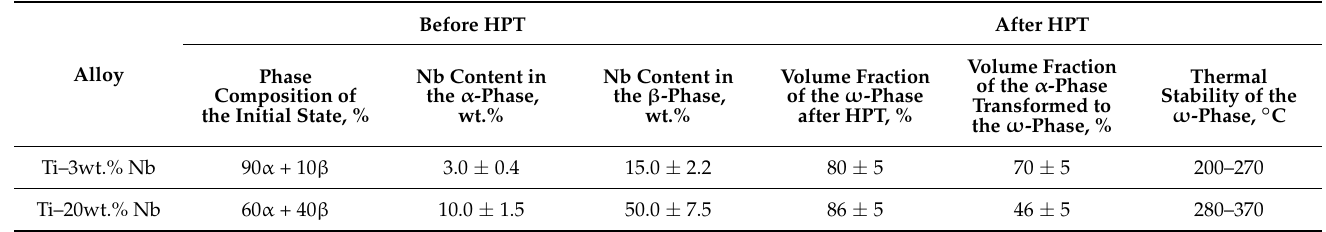
Table 2. The volume fraction of some phases before and after HPT (measured by synchrotron analysis), the Nb content in the α - and β -phases in the initial state and the thermal stability of the ω -phase (measured by the XRD in situ method). The chemical compositions of the α - and β -phases were measured by TEM